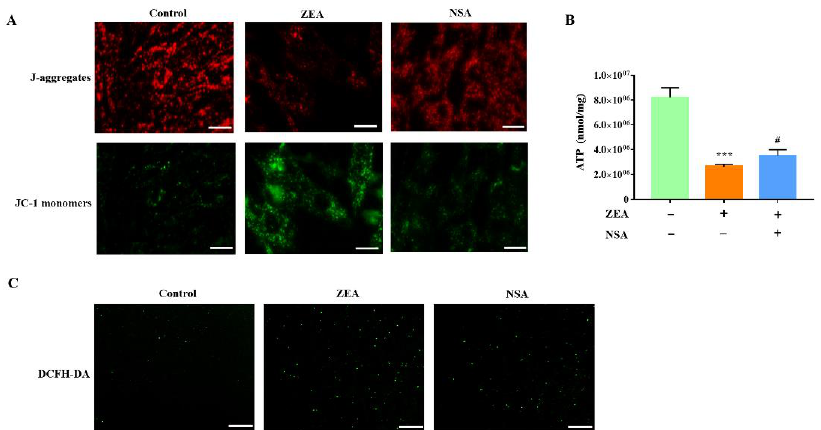
Figure 4. ZEA induces MLKL-mediated ROS overproduction and mitochondrial dysfunction in gESCs. Cells were pretreated with NSA (2.5 μM) for 2 h before treatment with ZEA (60 μM) for a further 24 h. ( A ) Mitochondrial membrane potential was measured by fluorescence microscope analysis of JC-1 staining. Scale bar, 20 µ m. ( B ) ATP content was determined using an ATP assay kit. ( C ) ROS generation was detected by DCFH-DA staining. Scale bar, 100 µ m. *** p < 0.001 vs. control group. # p < 0.05 vs. ZEA group.